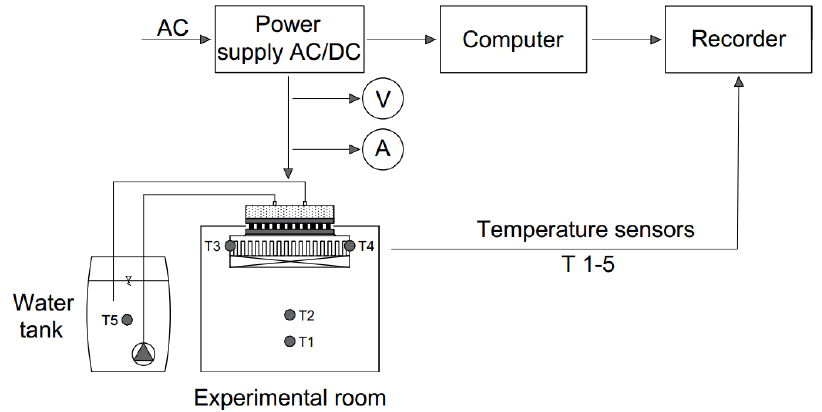
Figure 2. The scheme of the TE module power supply and measurement and recording system at the second stage of experiment including a network AC/DC power supply.